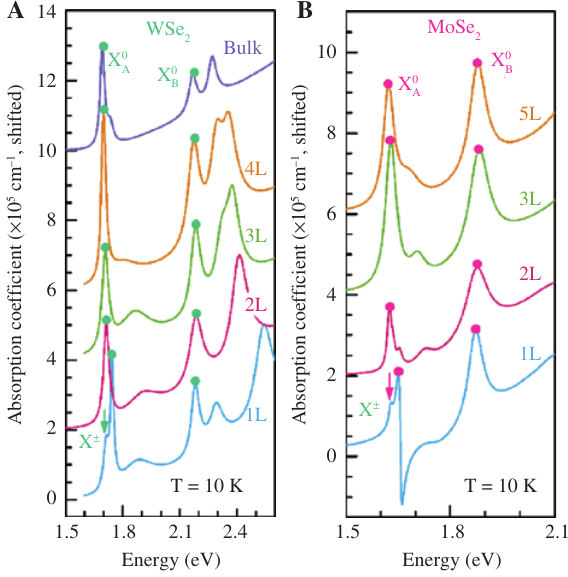
Figure 4: Absorption spectra (derived from reflectance contrast [10] and (B) MoSe [11] with increasing layer spectra) of (A) WSe 2 2 thickness, mentioned along with the respective spectra. The A and B exciton transitions, i.e. 0 X , are marked by X and 0 B A green and pink filled circles for (A) and (B), respectively. Addition- ally, a charged exciton peak is highlighted for the 1L case in the two plots by arrows.